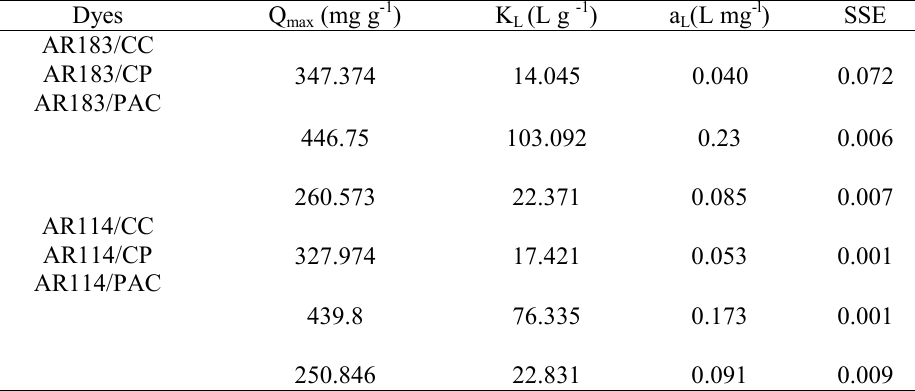
Table 1. Langmuir isotherm constants of AR/ Adsorbent